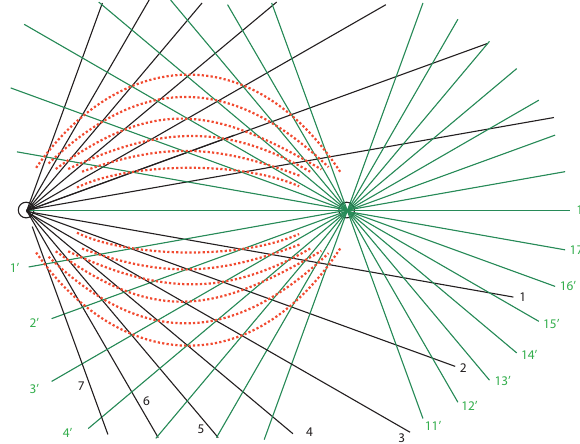
Fig. C2. Superposition of the equi-gauge potential lines 3 = const of two anti-parallel magnetic field lines. The field lines are shown in their cross sections with the left field line pointing out of the plane and the right field line pointing into the plane being spatially separated by some distance d . The equi-gauge potentials are again clockwise numbered consecutively. Because of the opposite direc- tion of the field in the right field line the primed equi-gauge poten- tials are numbered anti-clockwise. Addition of the equi-gauge po- tentials yields the dashed equi-gauge superposition pattern of con- nected equi-gauge potentials in the region between the field lines. Such a pattern indicates attraction between the oppositely directed field lines mediated by the gauge